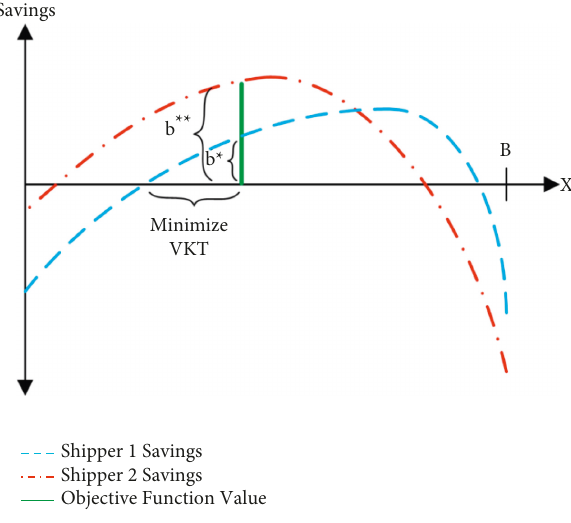
Figure 5: Minimum VKT objective